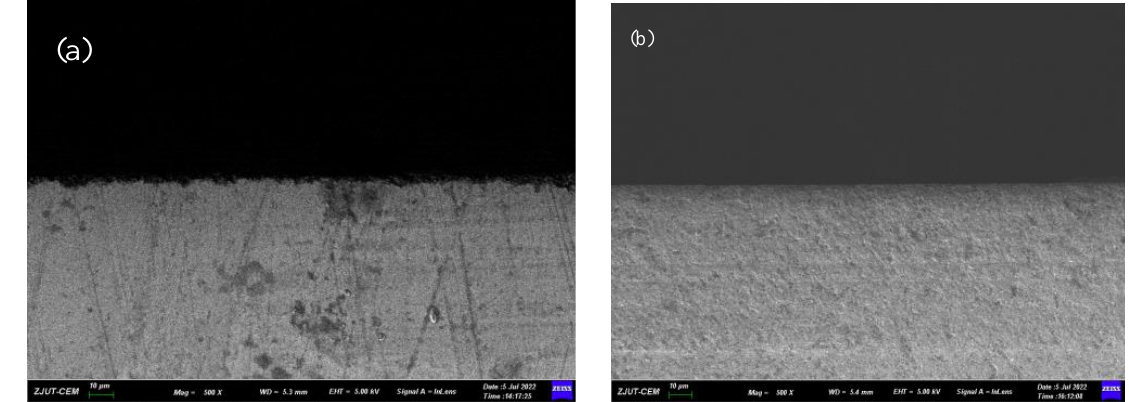
Figure 20. SEM images of cutting edge. ( a ) before the preparation, ( b ) after the preparation.